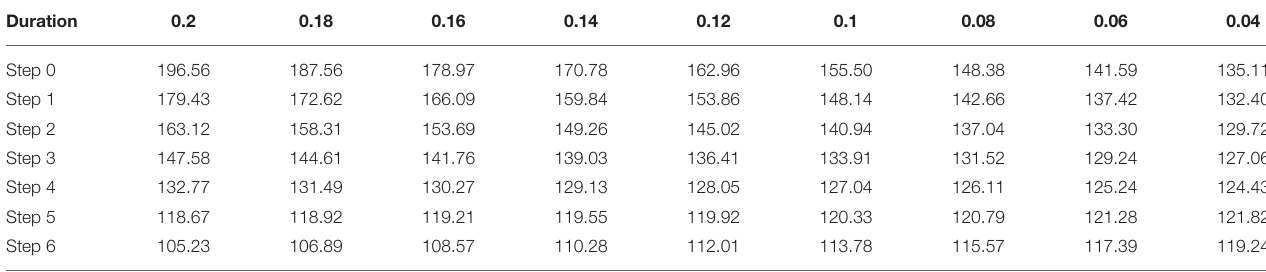
TABLE 3 | Offset values for each step varied by duration for linear falling pitch directions. Duration